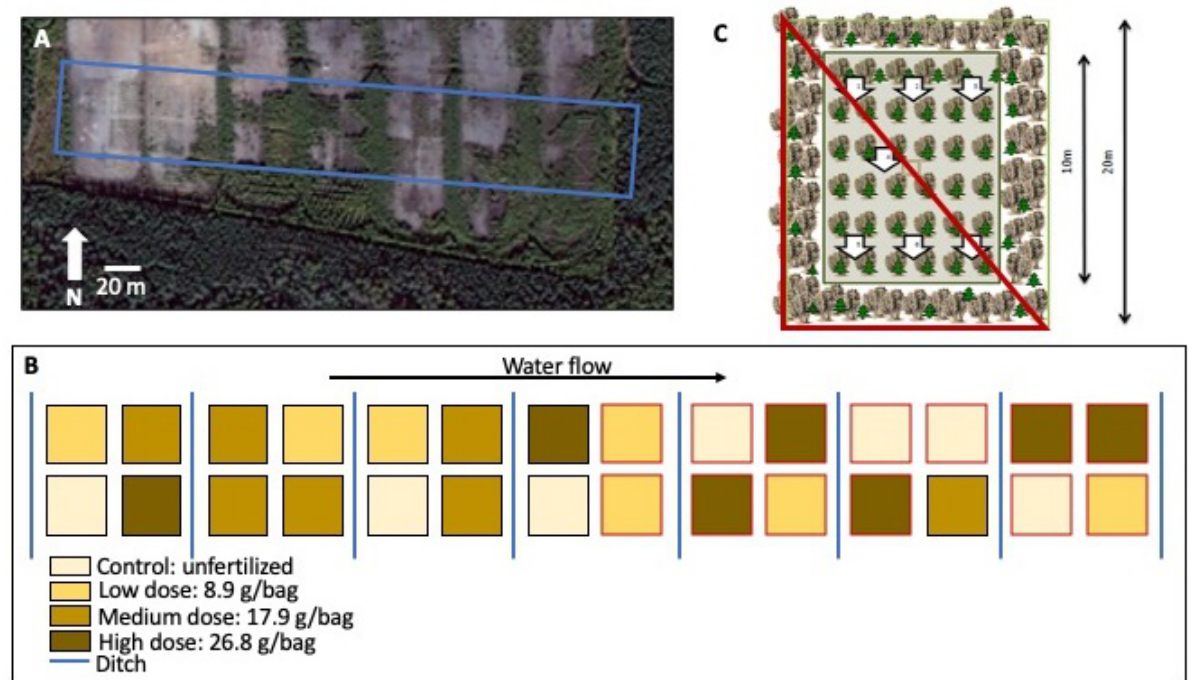
Figure 1. Map and schematics of the study site. (A) A satellite image of the study area with fertilizer treatment experimental units (EUs) and birch removal sub-units visible (source: maps.google.ca). The area outlined in blue is expanded as a schematic of the study areas in (B) showing the layout of the fertilizer doses and EUs used for birch removal (outlined in red). (C) A schematic of tree and soil measurements within the EU, within the 36 inner trees to avoid edge effects. B. papyrifera main stems present within a radius of 50 cm of the main planted P. mariana stem were assessed. Arrows show the positions for volumetric water content (Ɵ) measurements. The red triangle outlines the random selection of birch removal where the above-ground B. papyrifera were cut down around the planted P. mariana in selected